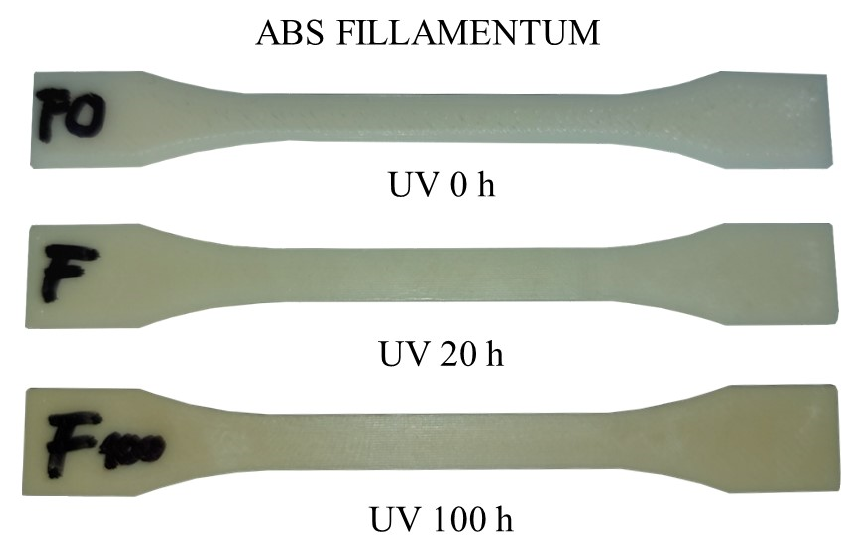
Figure 6. Color change due to UV radiation—Fillamentum ABS.